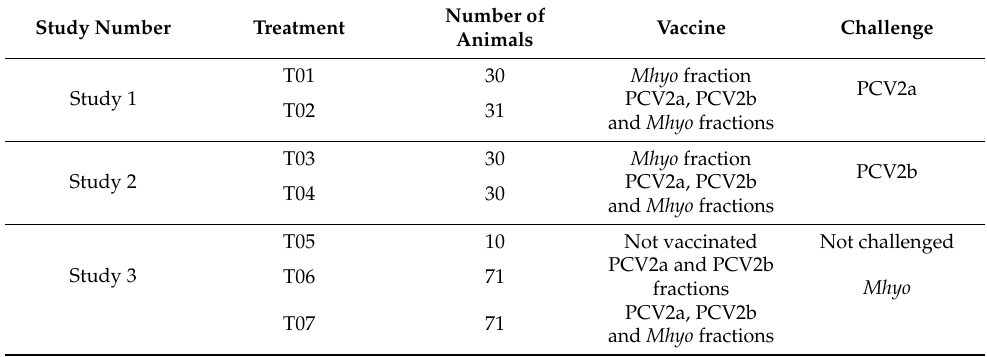
Table 1. Independent studies, treatment groups, and vaccination and challenge patterns involved in this